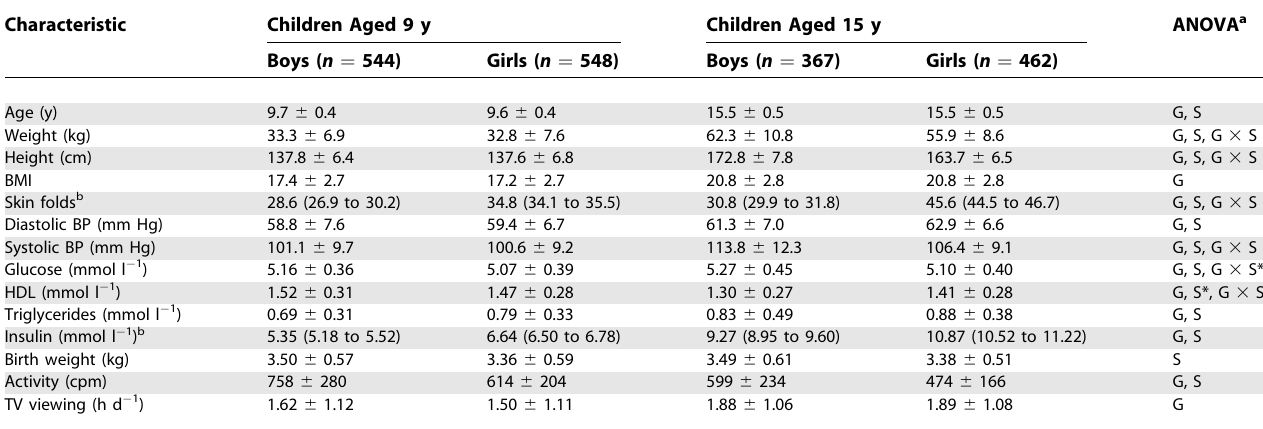
Table 1. Descriptive Characteristics of Participants Characteristic